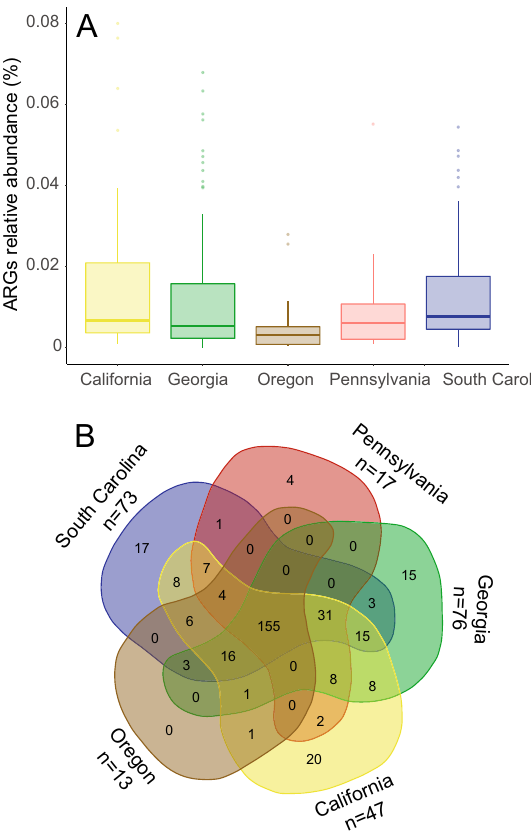
Figure 4. Antibiotic resistance genes characterization by state. ( A ) Relative abundance (%) of antibiotic resistance genes (ARGs) compared to overall microbiome composition identified by state. ( B ) Venn diagram showing shared ARG types by state. 155 ARGs types were core to all states (center of diagram), with unique ARG types identified in single state reported at the edge of the diagram. N ’s represent number of patient samples by